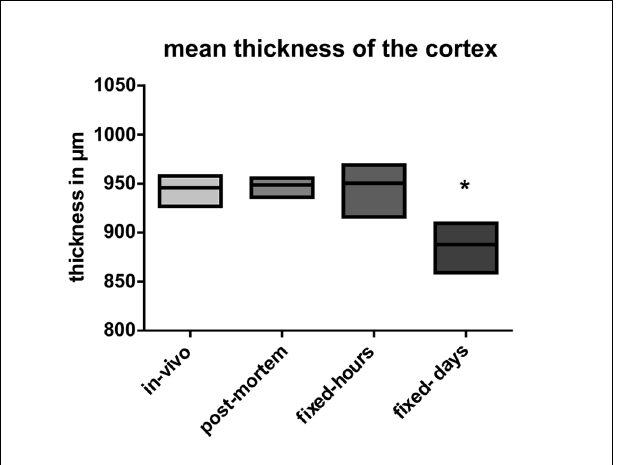
FIGURE 4 |Analysis of the mean thickness of the cortex. Data are presented as mean ± min to max (* p ≤ 0.05; ANOVA;Tukey’s post hoc test). In vivo : data from the in vivo scanning procedure; post-mortem : data obtained by using post-mortem brains; fixed-hours: data obtained by using extracted brains that were fixed for some hours; fixed-days: data obtained from extracted brains that were fixed for several